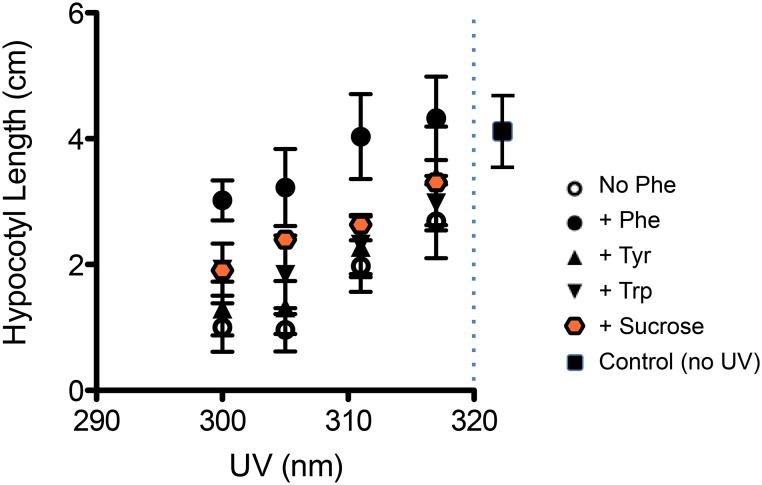
Phe prevents deleterious effects of UV-B, not duplicated by tryptophan, tyrosine or sucrose.Images of seedlings grown and exposed to UV radiation (300, 305, 311, 317) as described in Fig. 1, except that seedlings were grown on media with (+) and without (–) inclusion of 500 µM Phe, or 500 µM tryptophan (Trp) or 500 µM tyrosine (Tyr), or 2% final volume sterile-filtered sucrose (Sucrose) at the time of seed sowing. Hypocotyls were measured in cm 5 d after irradiation. Symbols are indicated on the Figure. Some of the symbols plotted are obscured, as there were nearly coinciding data points (i.e. tryptophan symbol is right behind sucrose for the 300 nm treatment).